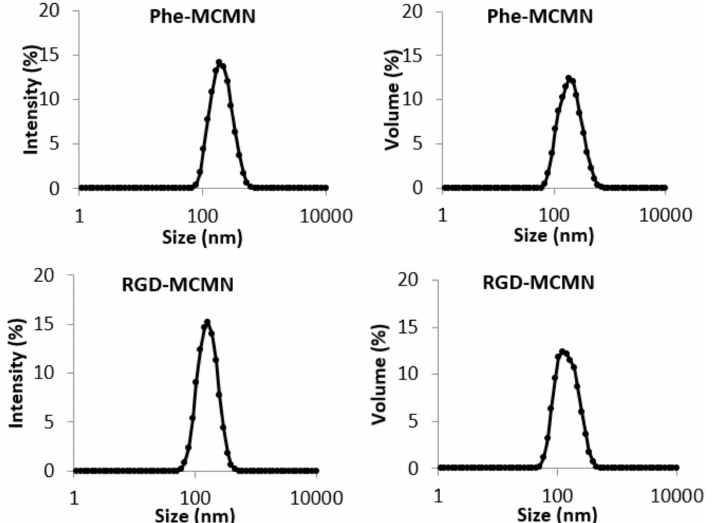
Figure 1. Diameter distribution profiles by intensity and by volume of particles determined by photon correlation spectroscopy (PCS) for surface-functionalized metal-complex multi-wall nanocapsules using phenylalanine or RGD as ligands (Phe-MCMN and